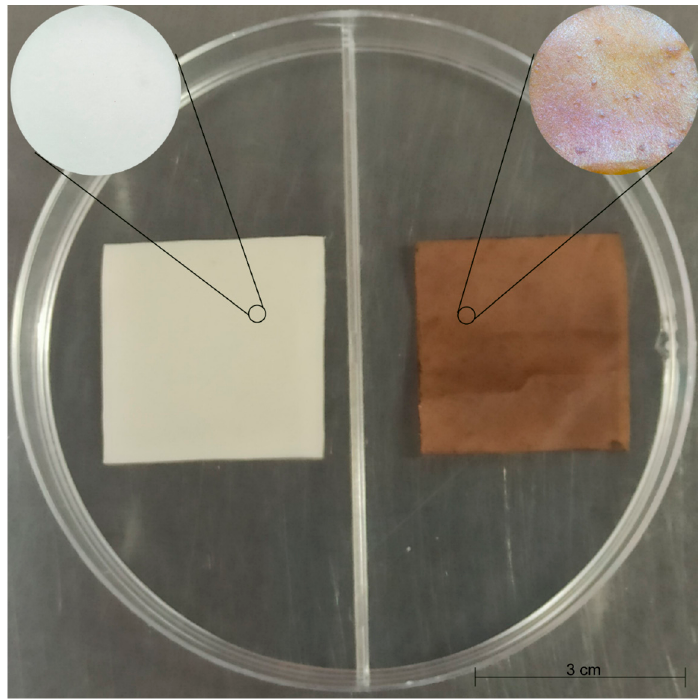
Figure 3. Biodegradable films with (brown) and without (white) bio-AgNPs. Film dimensions were 3 cm 2 . For the control film (white), 18.90% ( w / w ) of glycerol was used, while for the impregnated film (brown), 17.40% ( w / w ) of glycerol and 1.50% ( w / w ) of lyophilized bio-AgNPs were used.